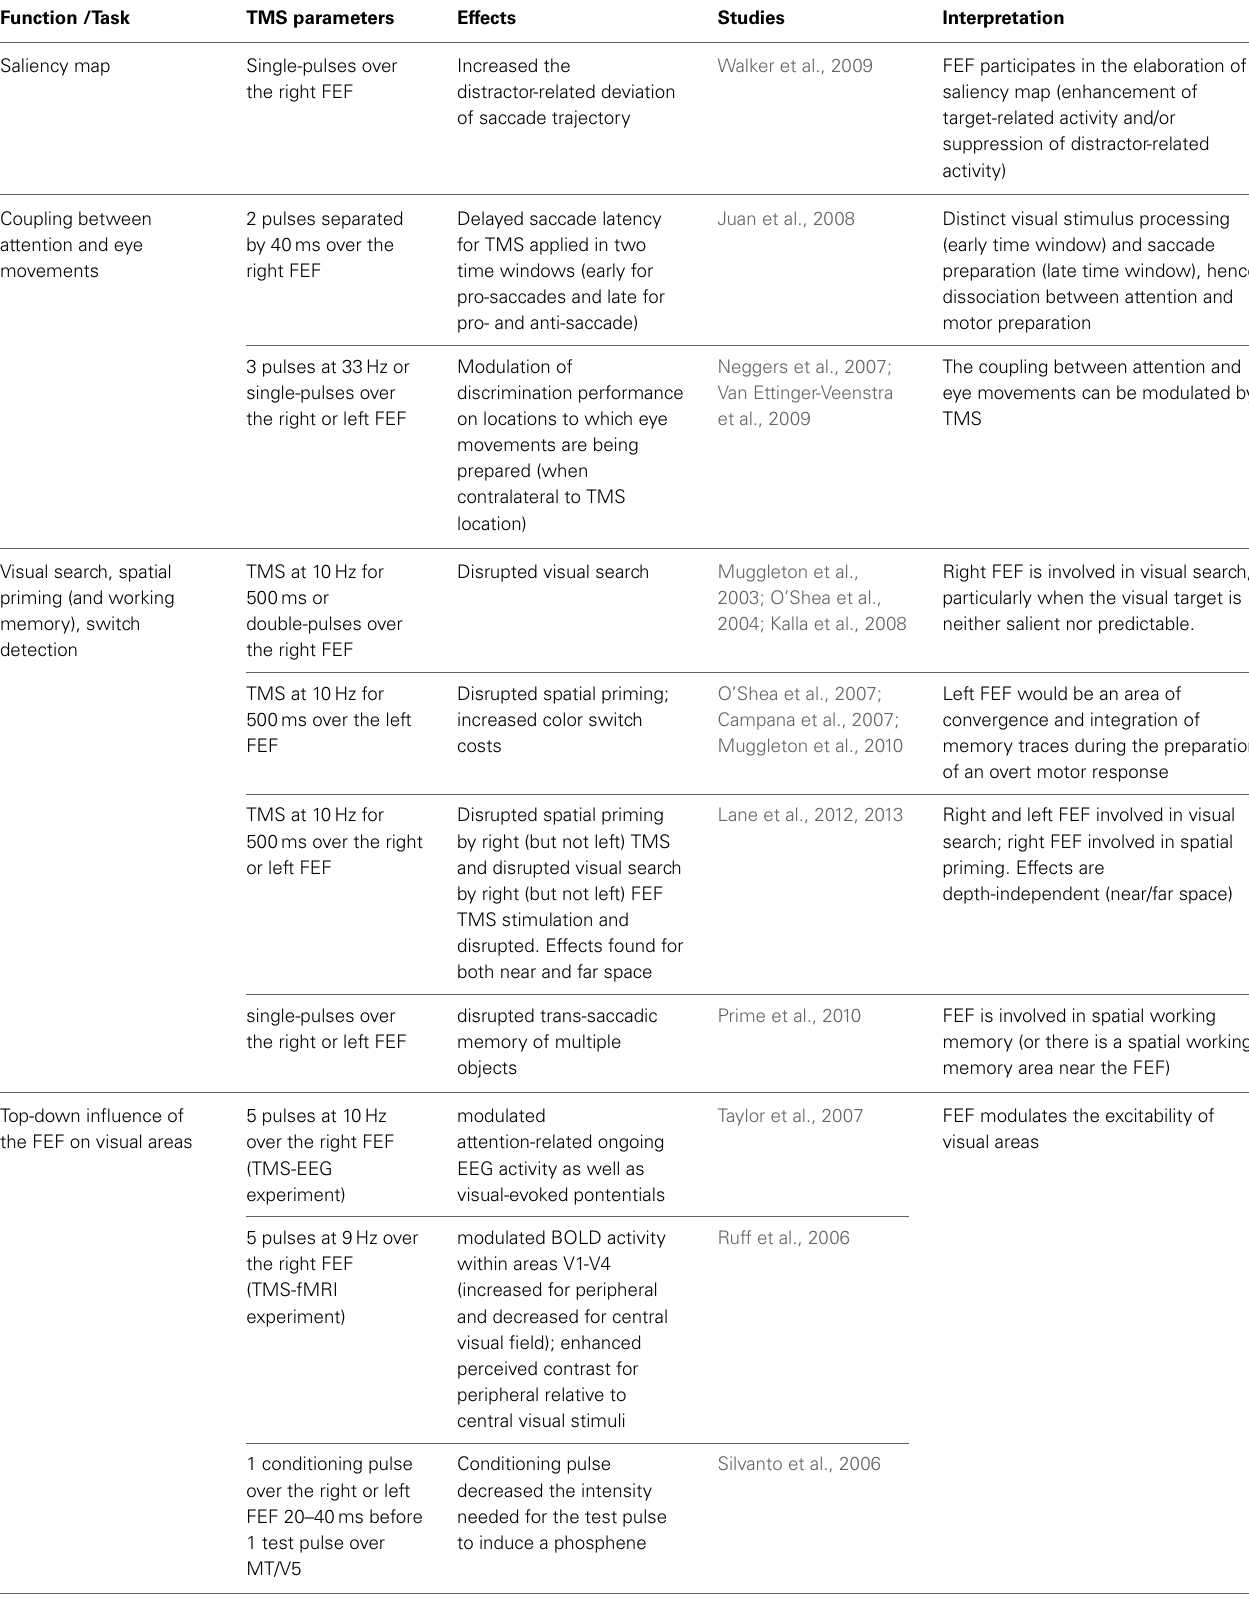
Table 6 | Effects of TMS over the FEF on visuo-spatial attention, visual awareness and perceptual modulation. Function